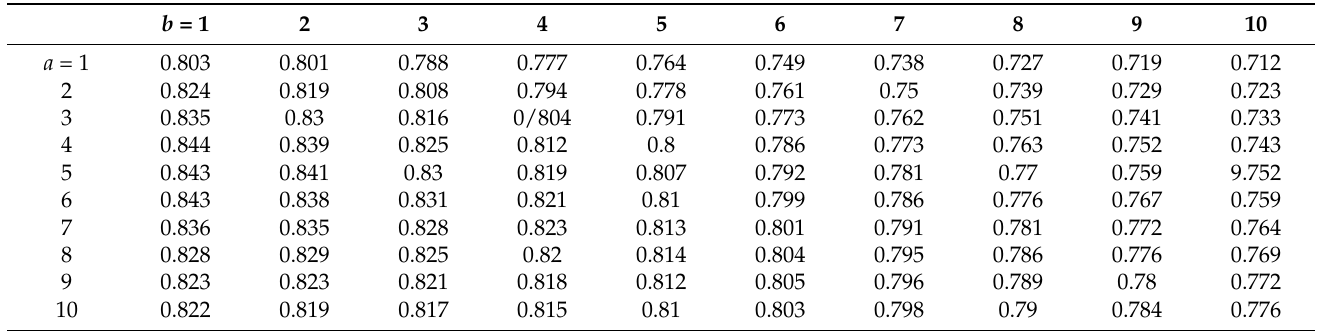
Figure 3. Receiver operating characteristic curves of revised (red) and adjusted (blue) Tokuhashi scores ( A ) in the reference group and ( B ) in the validation group. Abbreviation: AUC = area under curve; ATS = adjusted Tokuhashi score; RTS = revised Tokuhashi score. 4. Discussion Whether patients with spinal metastases can survive more than 6 months is a key factor for determining the treatment choice. However, recent studies have suggested that RTS tends to underestimate patients’ survival [11–15]. In this study, we found most mis-